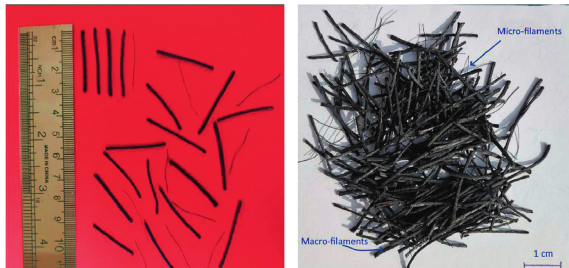
Figure 2: An overview of a random sample of